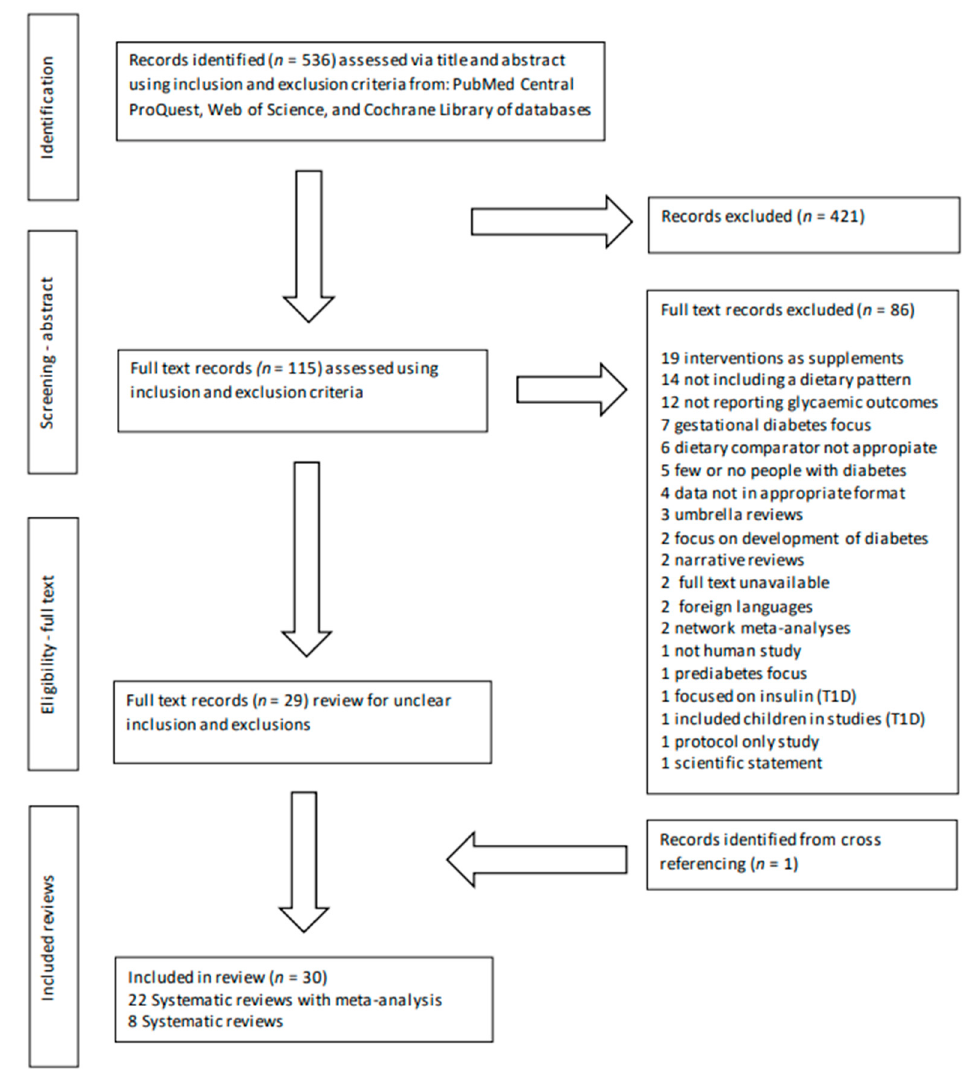
Figure 1. Review selection PRISMA flow diagram .